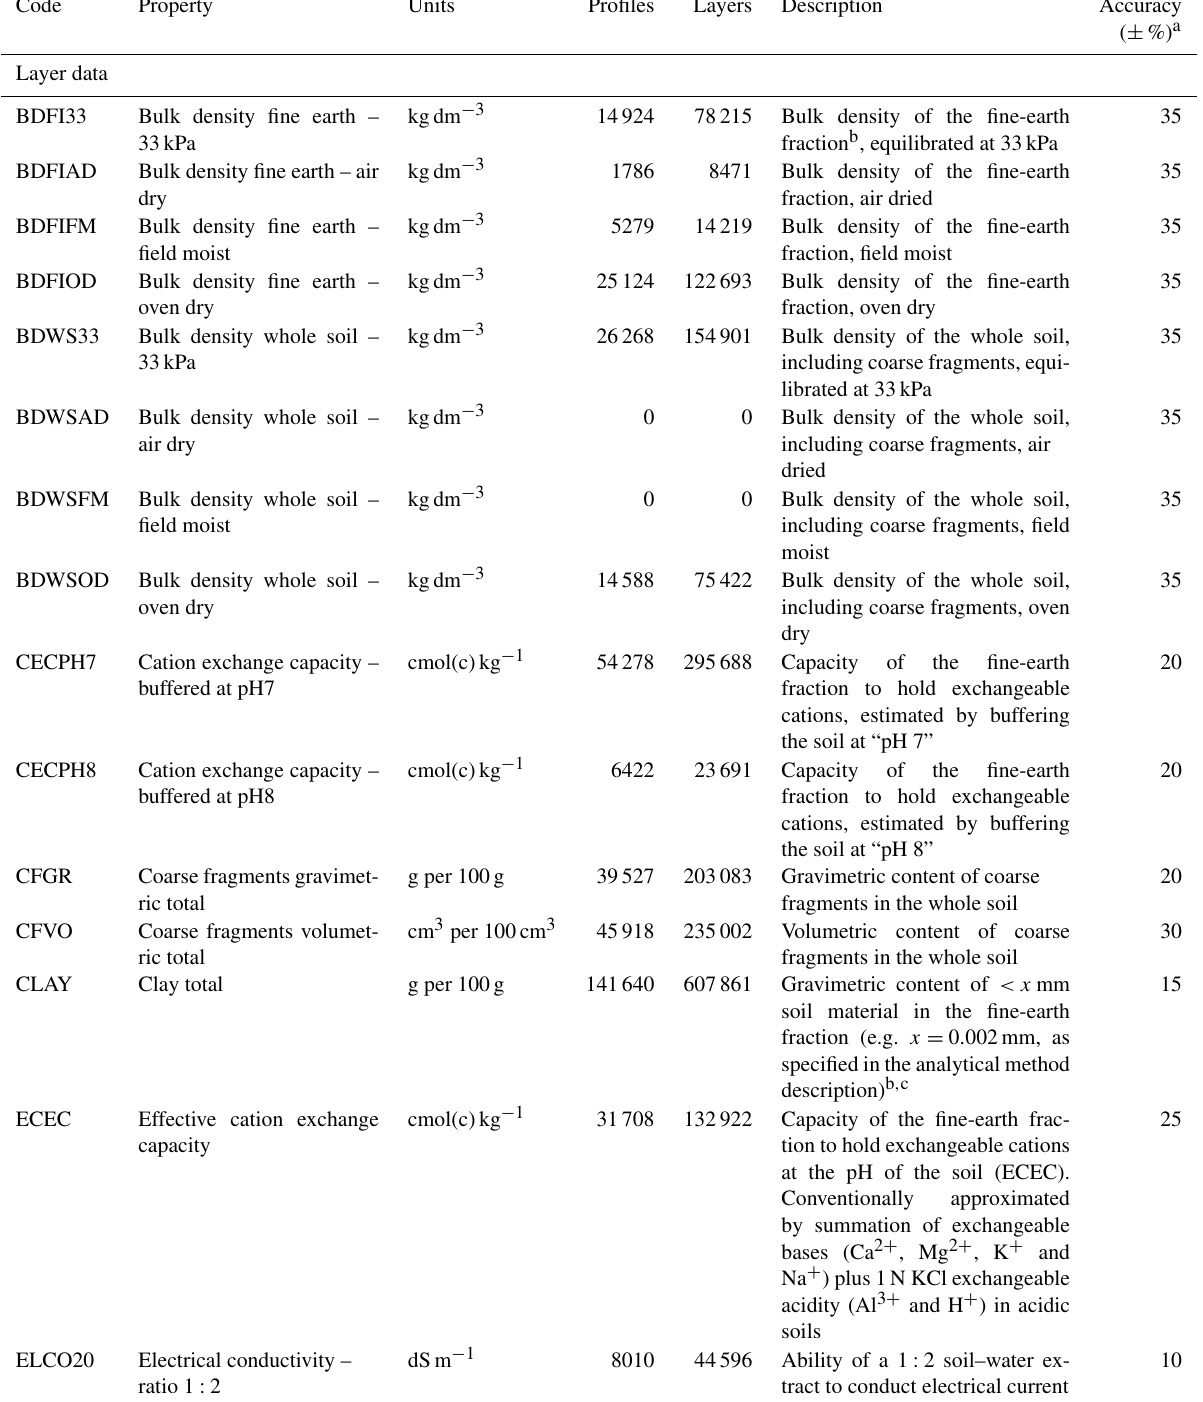
Table A1. Coding conventions and soil property names and their description, units of measurement, inferred accuracy, and number of profiles and layers provided in the “WoSIS September 2019” snapshot. Soil properties are listed in alphabetical order using the property